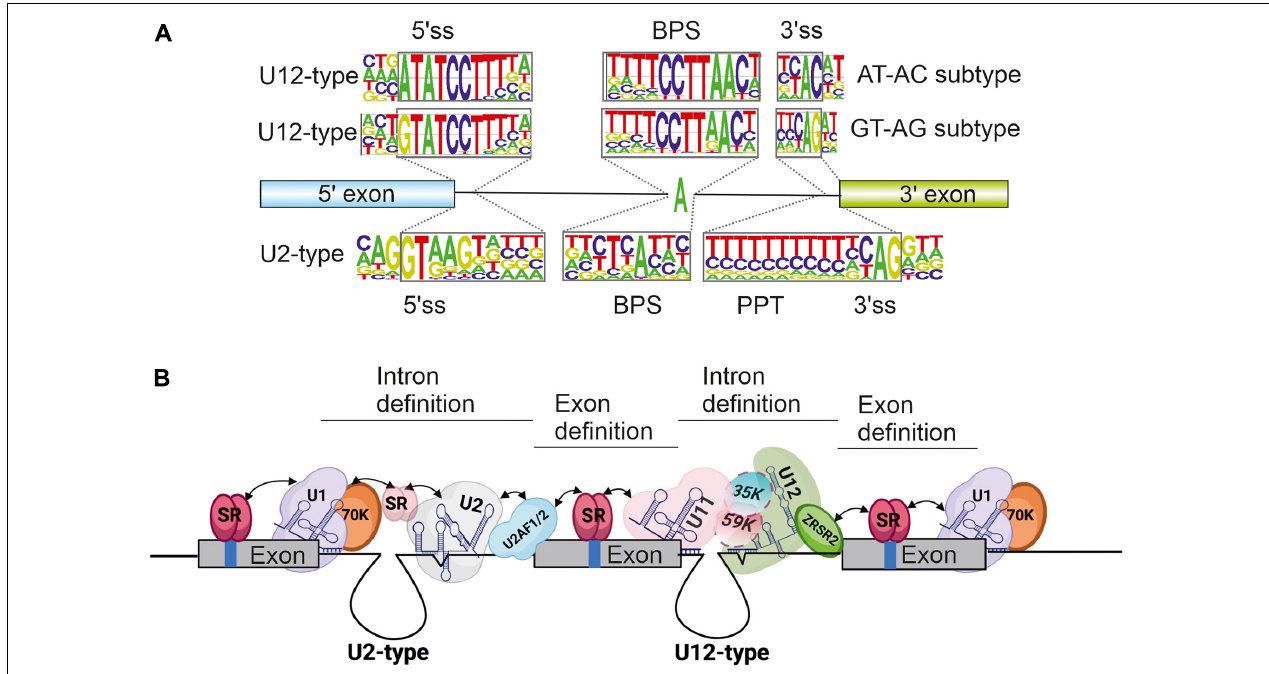
FIGURE 1 | (A) Consensus splice site sequences of minor and major introns. Minor or U12-type introns can additionally be grouped into AT-AC and GT-AG subtypes based on the first and last di-nucleotides. (B) Schematic of exon definition interactions taking place in a typical minor intron containing gene flanked by U2-type introns. Selected snRNA and protein components are indicated. Exons are depicted as solid boxes and introns as lines. Regulatory elements within exons are depicted as blue bars. Figure in panel (B) was modified from Turunen et al. (2013a). Created by